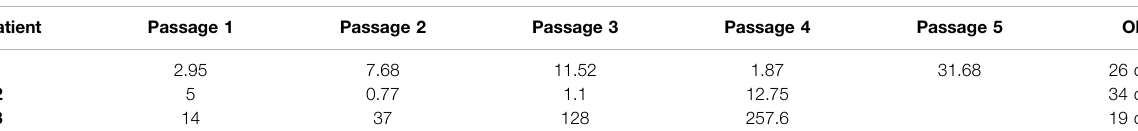
TABLE 5 | Cell density (x10 6 ) in different passages.